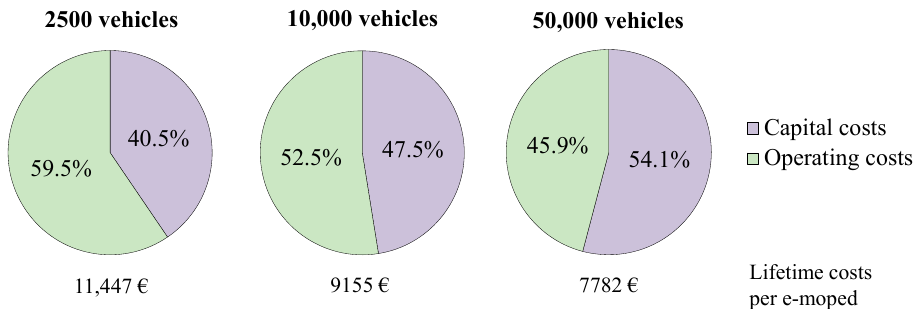
Figure 4. Share of lifetime capital and operative costs of e-moped fleets of main scenarios.